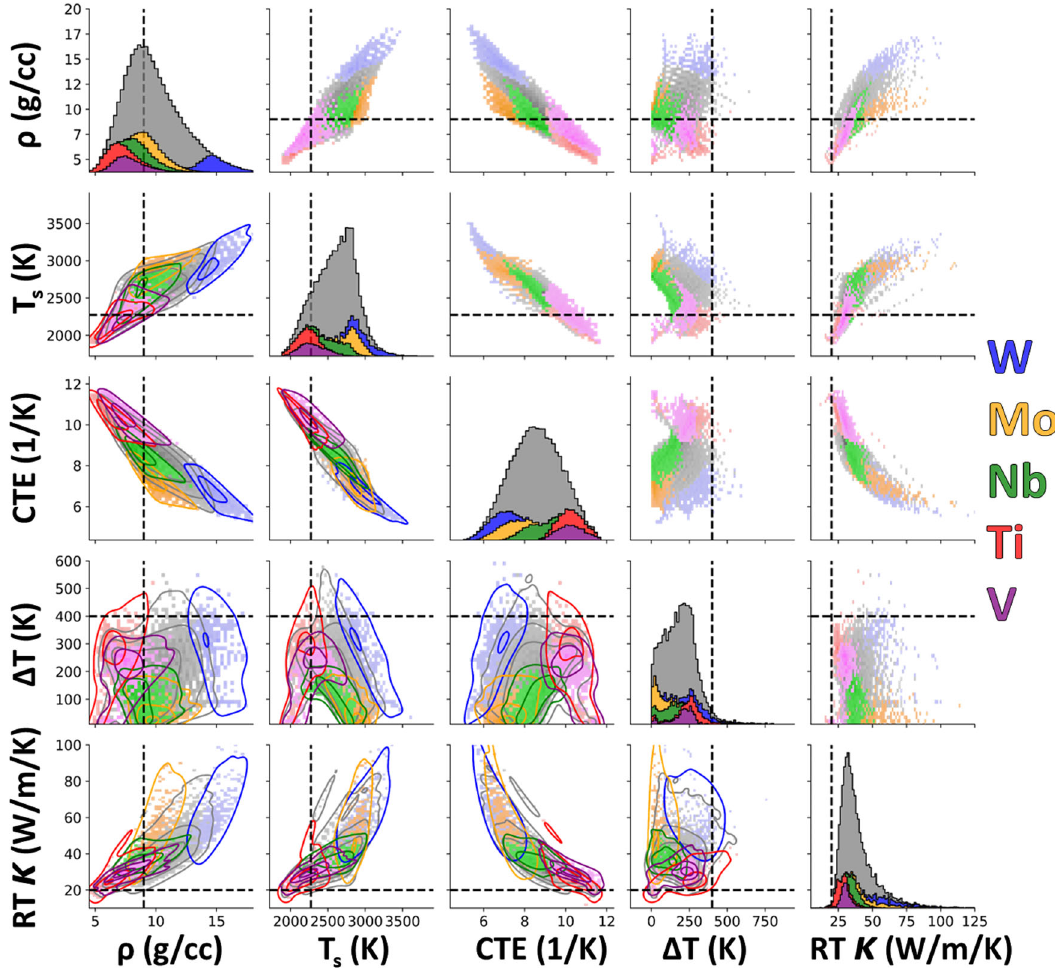
Fig. 5 Pairwise plot demonstrating correlations and trade-offs between the 5 constraints applied to the design space. Alloys that are comprised of more than 50% of a particular element are colored accordingly. Alloys that do not have a majority element are colored in gray. Diagonal rows depict property distributions for each class of alloy. The lower-left triangle depicts Kernel Density Estimate (KDE) estimates over joint property distributions to better visualize the structure of the